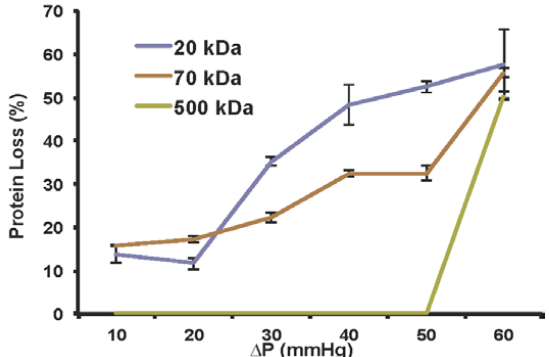
Figure 5. Filtration capability of podocyte membrane using dextran with sizes of 20 kDa, 70 kDa, or 500 kDa. Data are shown as mean ± SD ( n = 3).